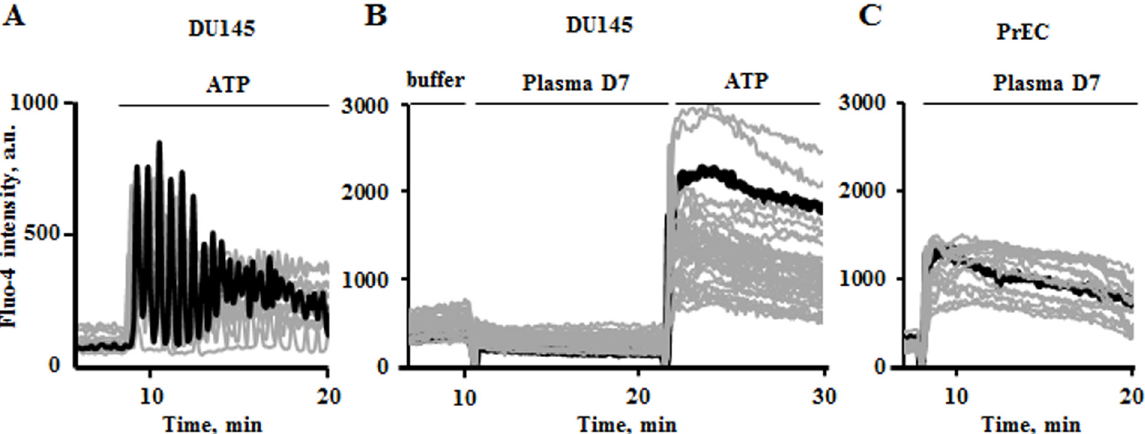
Fig 6. Plasma induced modulations of cytosolic calcium in PrEC and DU145 cells. Representative confocal microscopy spectral records of DU145 cells. After 10 minutes of incubation with or without plasma treated PBS cells were challenged with 50 μ M ATP. (A) IP 3 -mediated intracellular calcium oscillations induced by ATP were produced in control cells. (B) In plasma treated DU145 cells this amount of ATP provoked sustained cytosolic calcium response, while non-thermal plasma treated PBS itself did not cause calcium modulations. In PrECs the high calcium signal was observed right after addition of non-thermal plasma treated PBS (D7) (C). The representative original records demonstrate the data collected from about 50 cells evaluated in each of 5